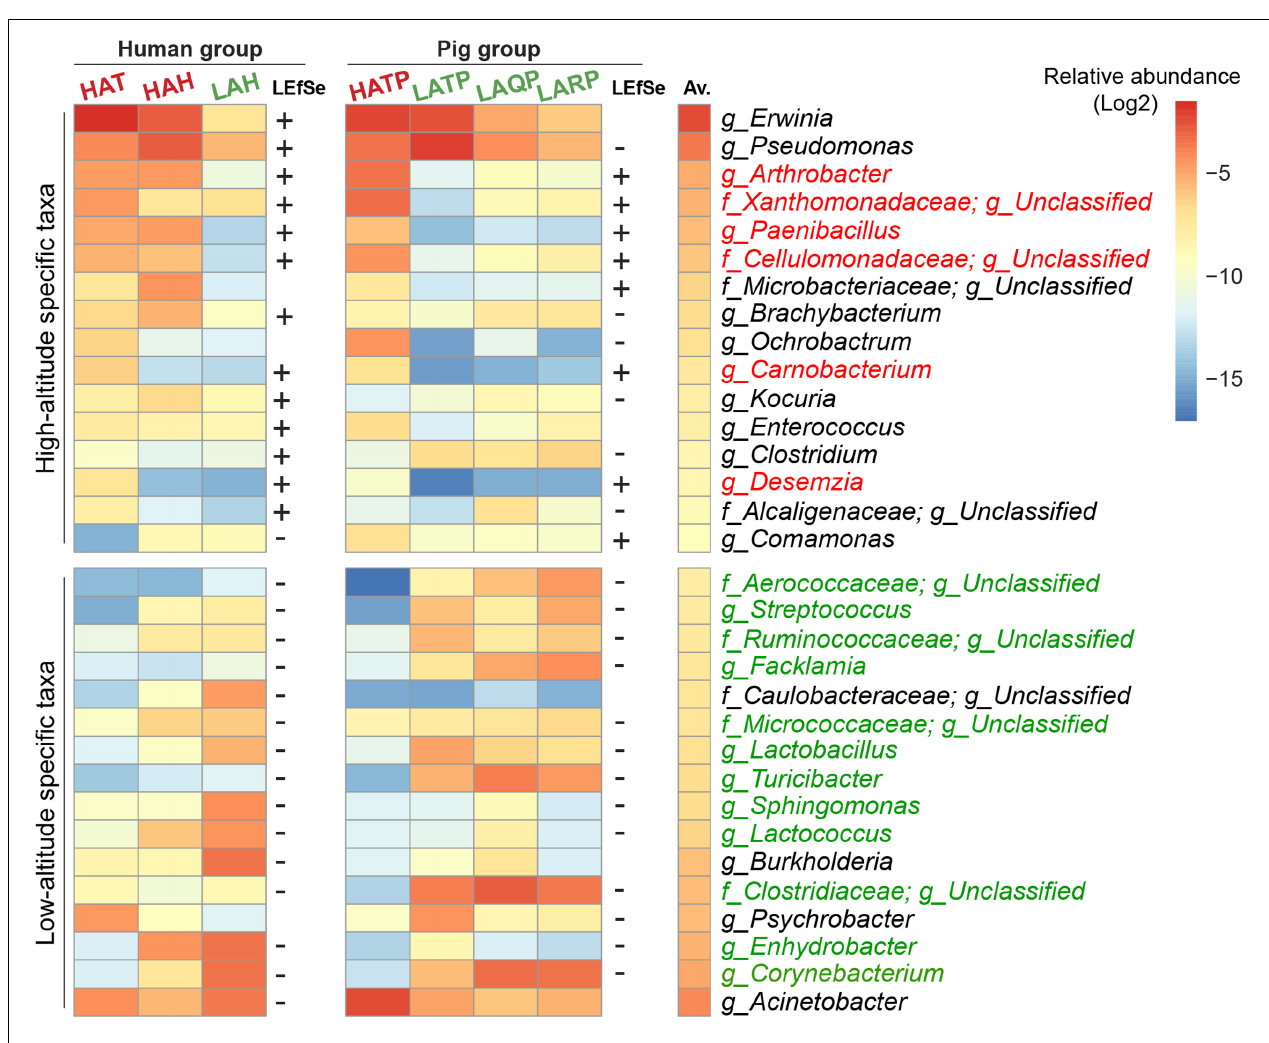
FIGURE 4 | Skin bacterial taxa associated with high and low altitude. The average relative abundance of the top 16 LEfSe-identified bacterial taxa in humans and pigs is plotted as a heatmap. “+” indicates significantly high abundance in high-altitude groups, “–” significantly high abundance in low-altitude groups ( p < 0.05, LDA cutoff = 2.0). Taxa that could not be annotated down to the family level or with conflicting results using LEfSe were omitted. Taxa names were colored (red, high altitude; green, low altitude) if LEfSe results were consistent in both human and pig groups. The Av. column indicates the total average relative abundance of each taxon across all